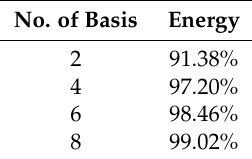
Figure 3. The space-time numerical reconstruction of SBE from Galerkin projection based reduced order model (G-ROM) (9) ( top row ) and EF-ROM (16) ( bottom row ) with dimension r = 4 ( left panel ), r = 6 ( middle panel ) and r = 8 ( right panel ), respectively. The noise path is the same as used in the numerical solution of the SBE field plotted in Figure 2. Table 1. The energy captured by the first few proper orthogonal decomposition (POD) bases from stochastic Burgers equation (SBE) data with σ =